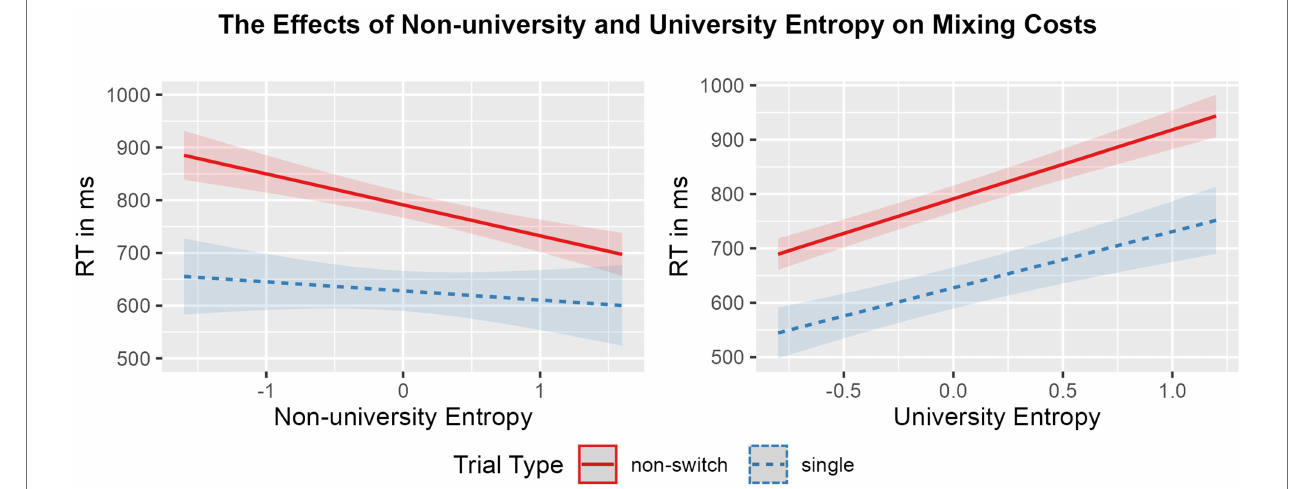
FIGURE 3 | Regression model plot of the interaction between non-university entropy ( left panel ) and university entropy ( right panel ) and trial type (blue striped: single; red solid: non-switch) on RTs (ms). Shading represents the size of the confidence bands.